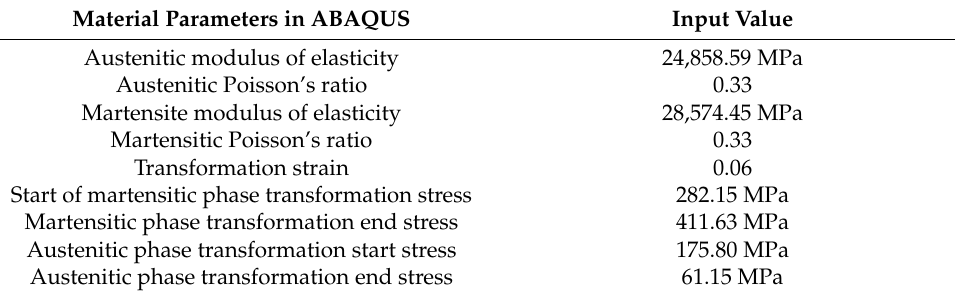
Table 1. Ontogenetic parameters of